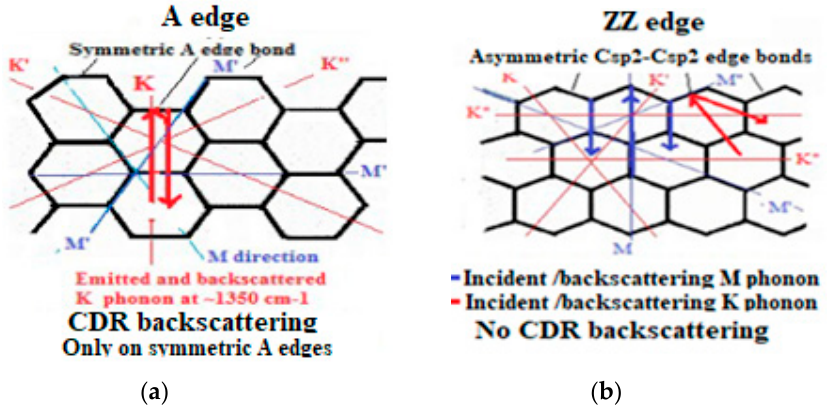
Figure 14. Phonon backscattering and Raman conditions at 1350 cm − 1 . ( a ) CDR Raman scattering conditions are fulfilled on a symmetric A-edge and for which in-plane K phonon at ~1350 cm − 1 is perpendicular to A-edge. No CDR Raman scattering on asymmetric graphene A edge of respective K’, K” orientation. ( b ) No 0° angle backscattering on the ZZ edge for K and M phonon at ~1350 cm − 1 where edge Csp2-Csp2 bonds are not symmetric to the K orientation. M phonon can be split in other phonon of lower energy and therefore, no CDR Raman at 1350 cm − 1 can exist on ZZ edge.